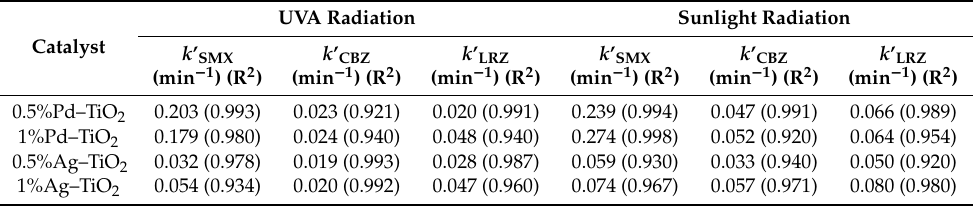
Table 1. Pseudo-first-order kinetic rate constants ( k ’) for SMX, CBZ and LRZ degradation during photocatalytic oxidation for di ff erent catalysts and radiation sources. The respective determination coe ffi cients (R 2 ) are between